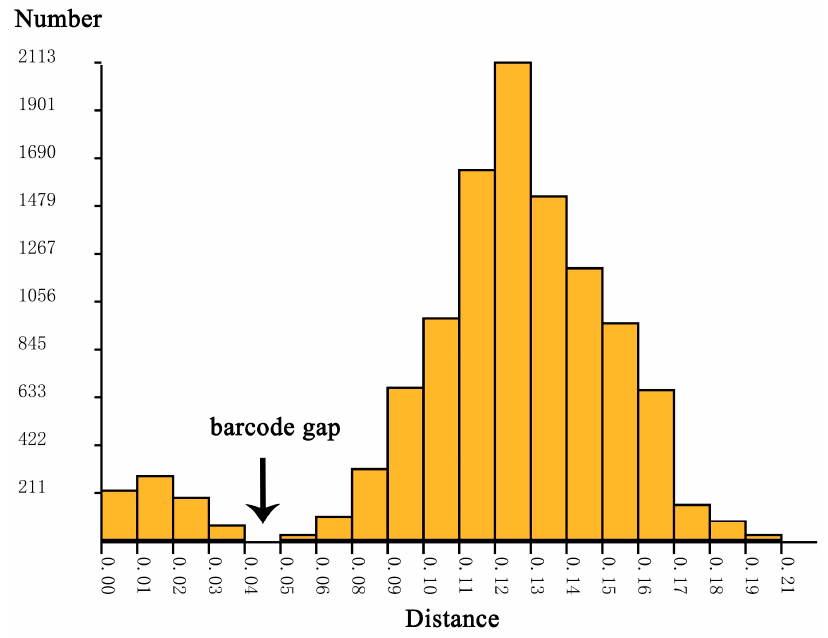
Figure 2. Histogram of pairwise K2P distances between morphological species of Microtendipes . The horizontal axis shows the pairwise K2P distance, the vertical axis shows the number of pairwise sequence comparisons, and the black arrow indicates the barcode gap.